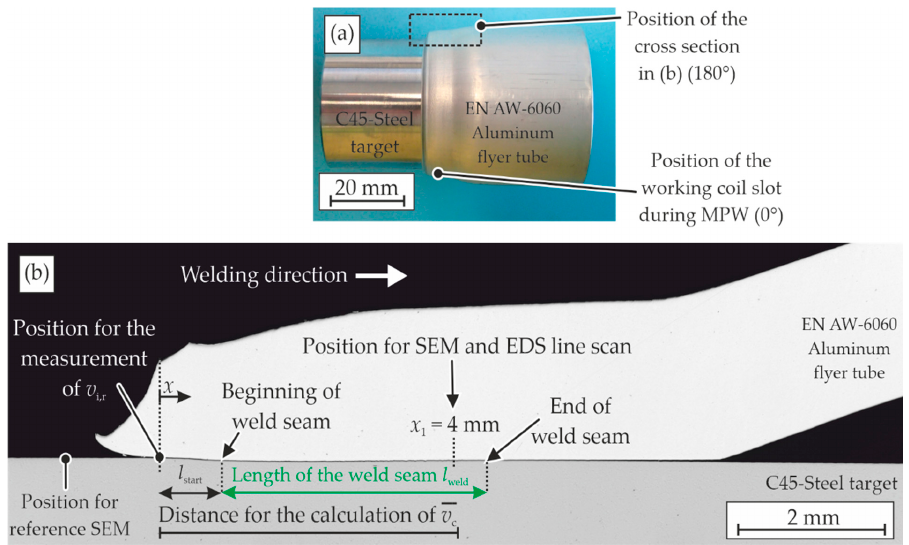
Figure 2. ( a ) Sample after MPW; ( b ) exemplary cross section with indicated position of the weld seam, SEM and EDS line